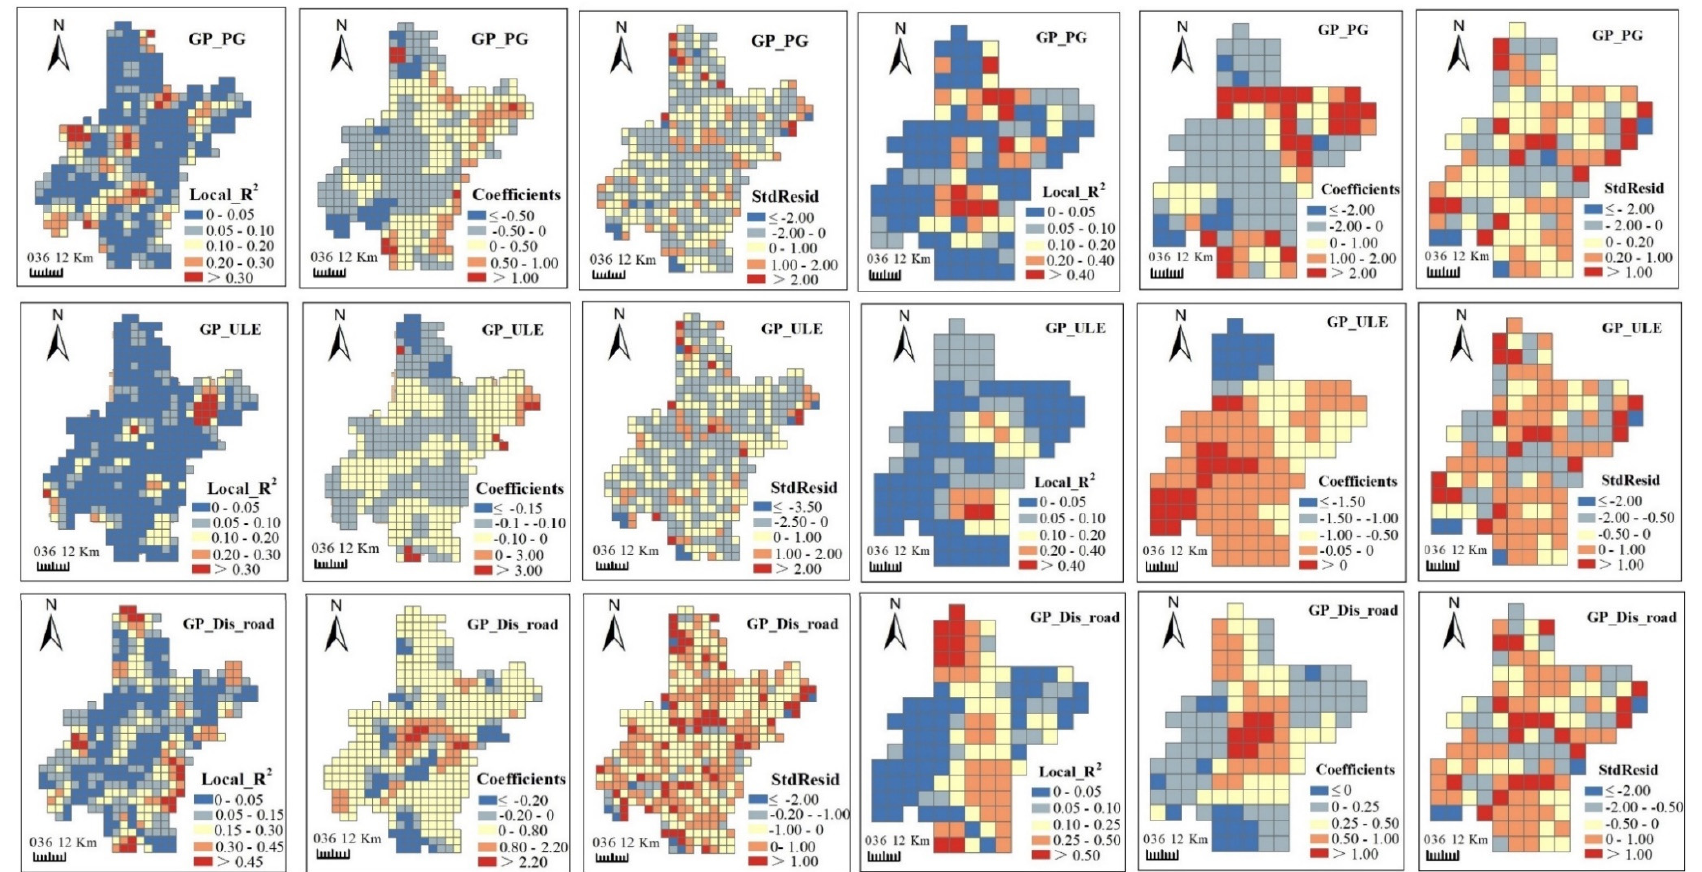
Figure 6. Spatial patterns of local R 2 , coefficients and standard residuals (StdResid) from geographically weighted regressions (GWRs) between grain productivity (GP) and urbanization indicators at 5 km ( left three columns ) and 10 km ( right three columns ) grid scales. Abbreviations: Population growth (PG); Urban land expansion (ULE); Distance to major roads (Dis_road).